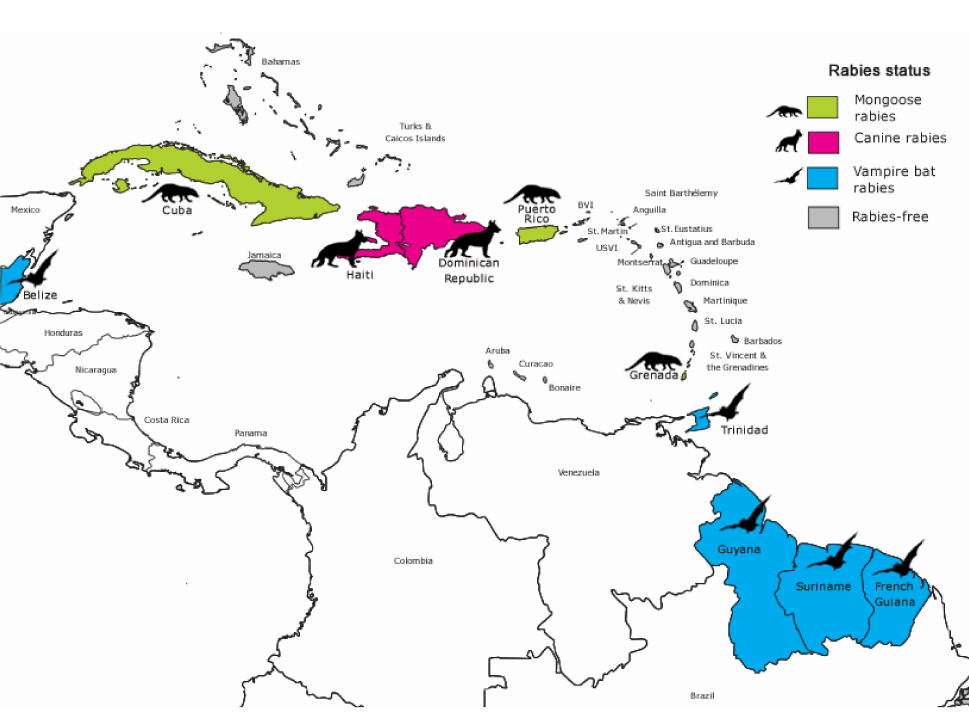
Figure 1. Main animal reservoirs for rabies virus and country endemic status in the Caribbean. At the time of survey administration, responses indicated that animal rabies cases were nationally notifiable in all rabies-endemic areas but in only 85% of non-endemic countries/ territories (see Table